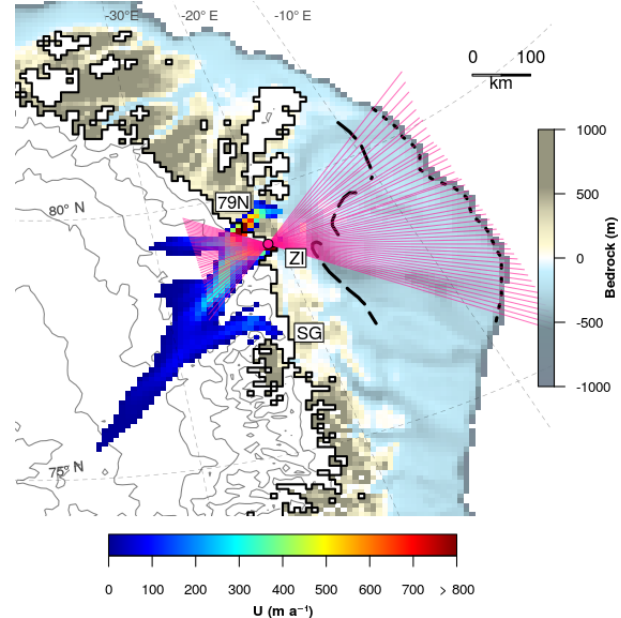
Figure 2. Map of the NEGIS sector showing the location of its three outlet glaciers (79N, ZI and SG), the observed present-day grounding-line position (solid black line), the observed present- day surface velocities (from Joughin et al., 2018), the offshore bathymetry and the onshore ice elevation (both from Schaffer et al., 2016) and the maximum (dotted black line) and minimum (dashed black line) grounding-line positions reconstructed for the LGM (Funder et al., 2011). The 48 transects used to calculate the evo- lution of the grounding-line position are shown in